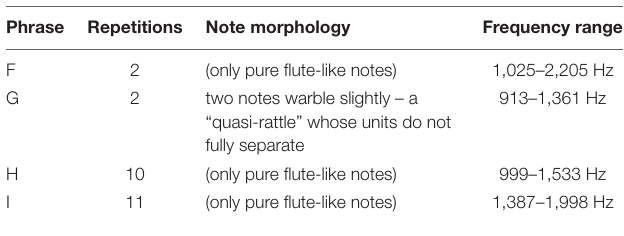
TABLE 2 | A summary of the immature bird’s phrases, delivered in Supplementary Audio 2 from 40:08 to 49:06 = 8 (cid:48) 58 (cid:48)(cid:48)